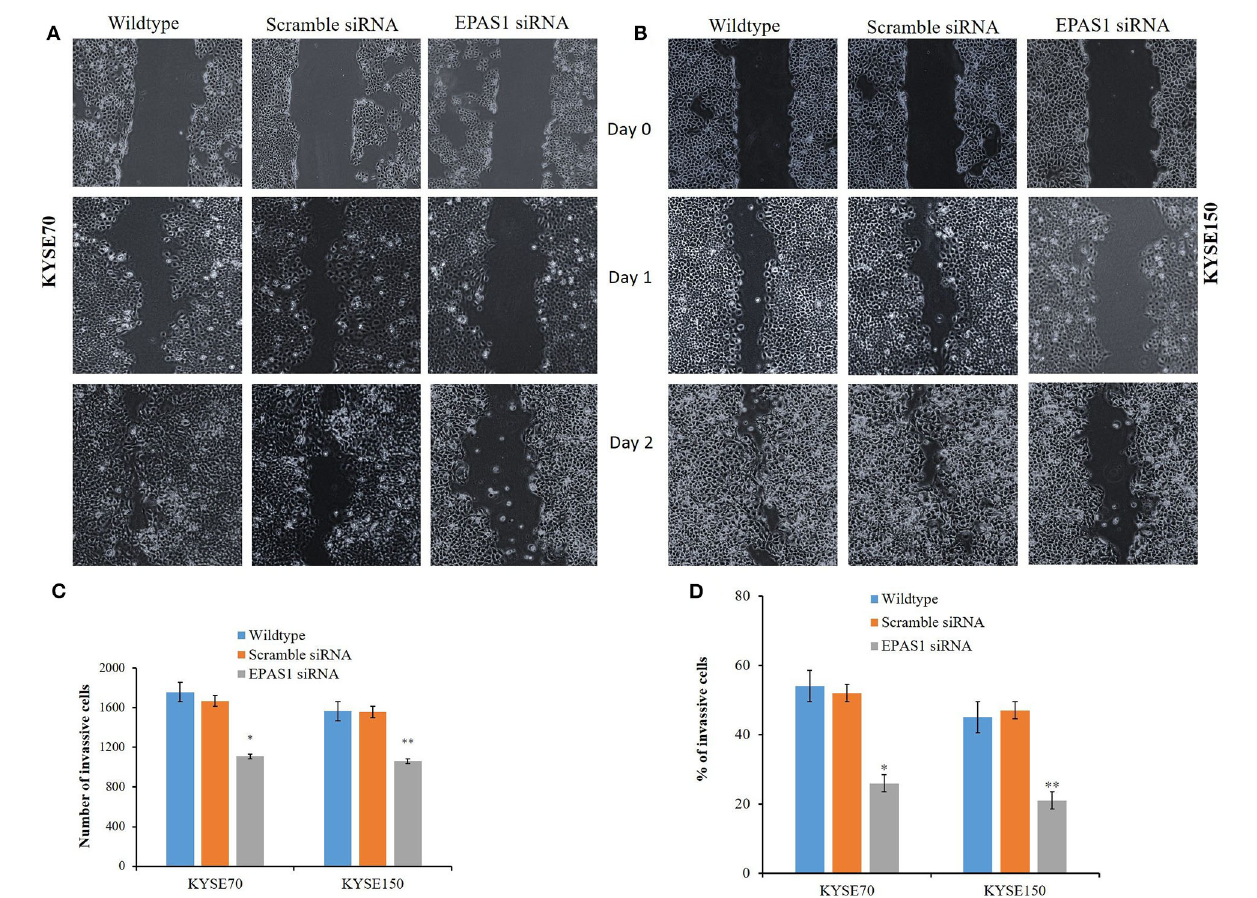
FIGURE 7 | Silencing of EPAS1 causes reduction of wound healing, invasion and migration of ESCC cells. Silencing of EPAS1 causes inhibition of wound healing of ESCC cells as suppression of EPAS1 induced reduction of migration capacity of KYSE70 (A) and KYSE150 (B) cells, thereby healing the wound more slowly in comparison to that of untreated wild type and scramble control cells. Similarly, a significantly reduced population of KYSE70 (C) and KYSE150 (D) cells exhibited invasion and migration followed by suppression of EPAS1 when compared to that of untreated or scramble control cells. Results are shown as mean ± SD, and significance level was taken at p < 0.05. * p < 0.05 and ** p <